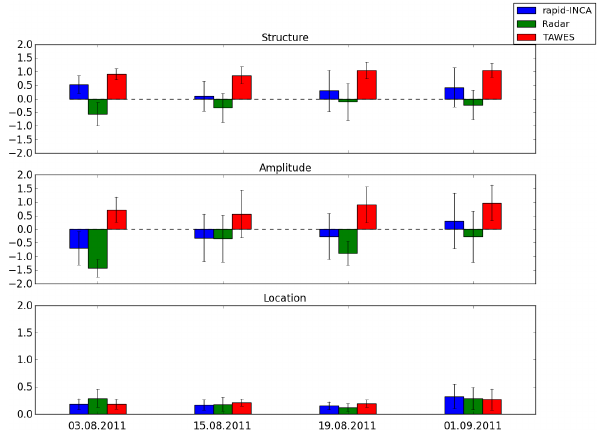
Figure 11. Structure, amplitude and location computed for each time step within the 2h intervals at each date and subsequently av- eraged. Error bars indicate the standard deviation of S, A, L time